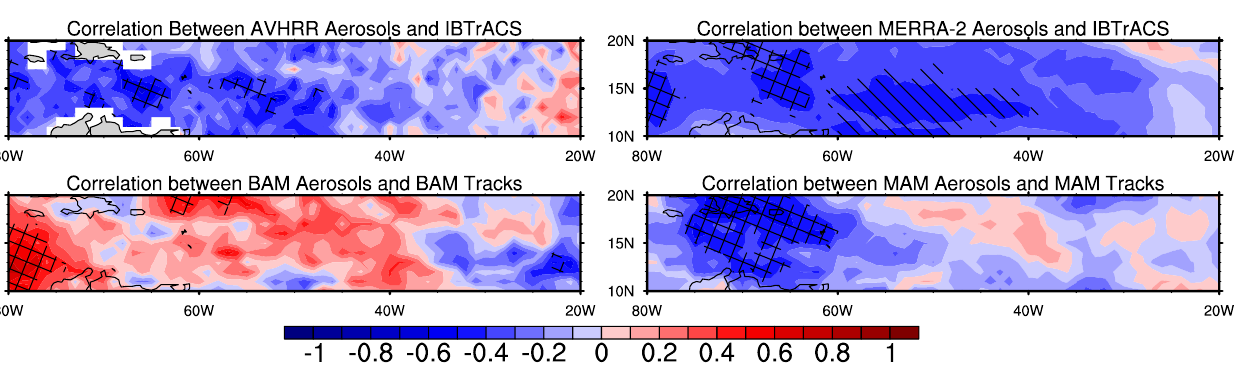
Figure 8. Correlations between the averaged AOD and track density over the MDR (10–20 N; 80–20 W) for ( first row ) observations and ( second row ) models. The cross hatching indicates 95% statistical significance, while the single direction hatching indicates 90% statistical significance. The AVHRR dataset excludes grid boxes that are considered